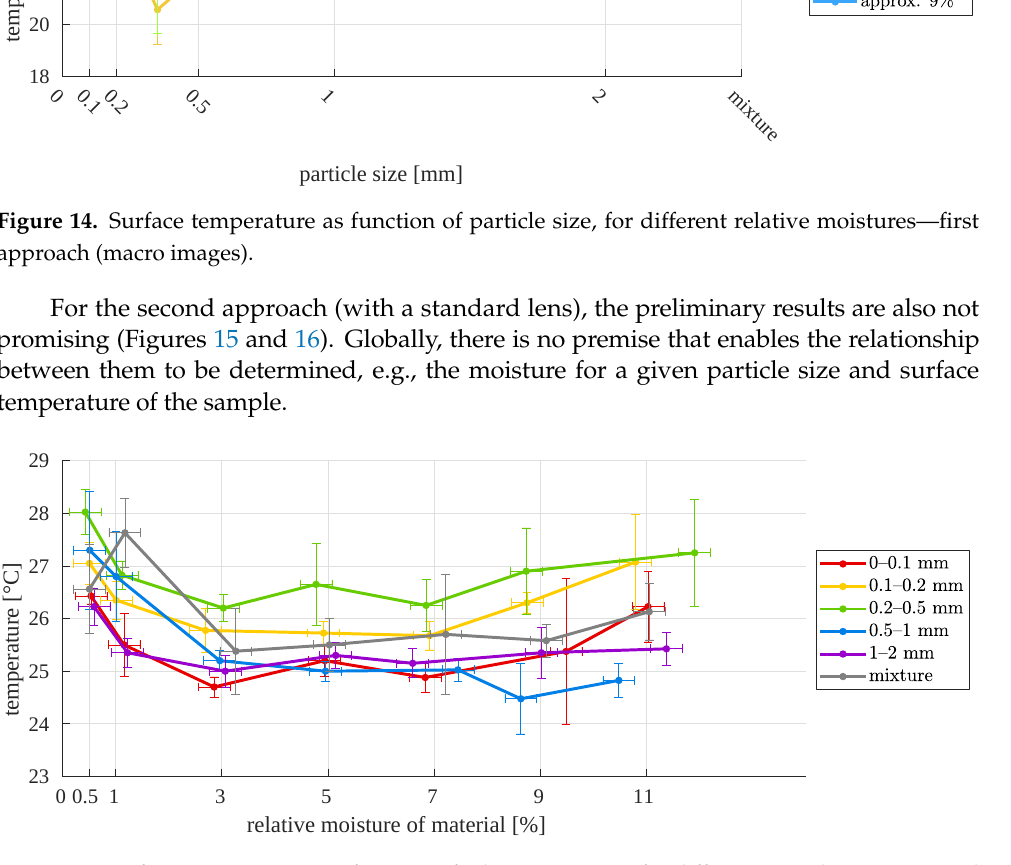
Figure 15. Surface temperature as a function of relative moisture, for different particle sizes—second approach (normal images).